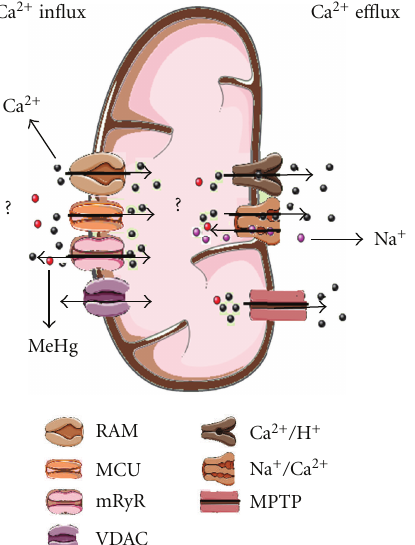
Figure 6: Representation of di ff erent channels responsible for Ca 2+ influx/e ffl ux in mitochondria and the possible interaction of MeHg with these channels. VDAC: outer membrane voltage- dependent anion channel; RAM: rapid uptake model; MCU: inner membrane calcium uniporter channel; mRyR: mitochondrial ryan- odine receptor; Ca 2+ /H + antiporter; Na + /Ca 2+ exchanger; MPTP: mitochondrial permeability transition pore. The scale of structures represented in this scheme does not represent the real